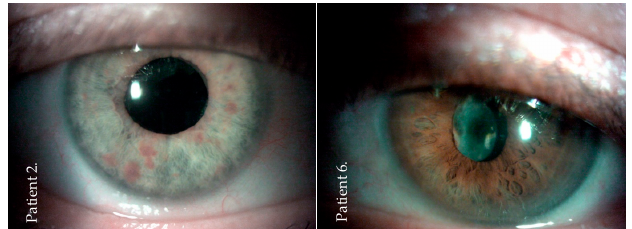
Figure 2. Slit-lamp image of the anterior segment at the final examination (after six months) of two patients (patients: numbers 2 and 6) after post-injection endophthalmitis. No conjunctival irritation but a clear cornea and a clear anterior chamber were observed. There was posterior capsule opacification in patient number 6.